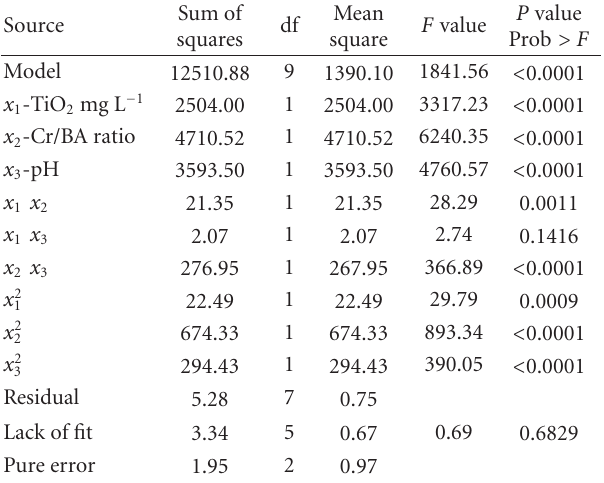
Table 3: Analysis of variance (ANOVA) for % degradation of benzoic